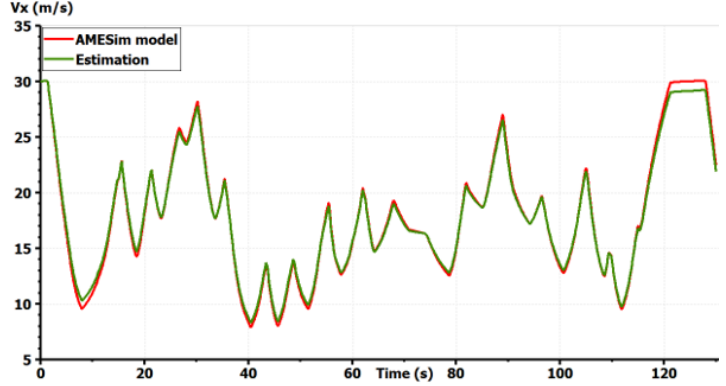
Figure 6. Validation of the vehicle model: longitudinal speed